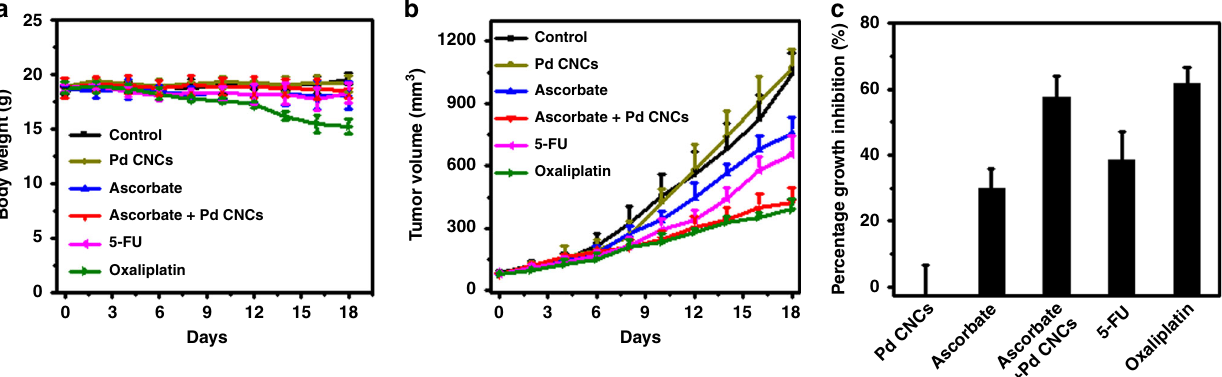
Fig. 7 Effects of Pd CNCs on ascorbate-induced cytotoxicity in vivo. The current clinical medicines, oxaliplatin and 5- fl uorouracil (5-FU), are also included for comparison. a Average weight of mice with HCT116 xenografts after different treatments. b Tumor growth curves from HCT116 tumor xenografts in 6 – 8 week athymic nude mice with ascorbate or Pd CNCs. c Percentage of growth inhibition of mice after the treatment. For all in vivo studies, mice n = 5 per treatment